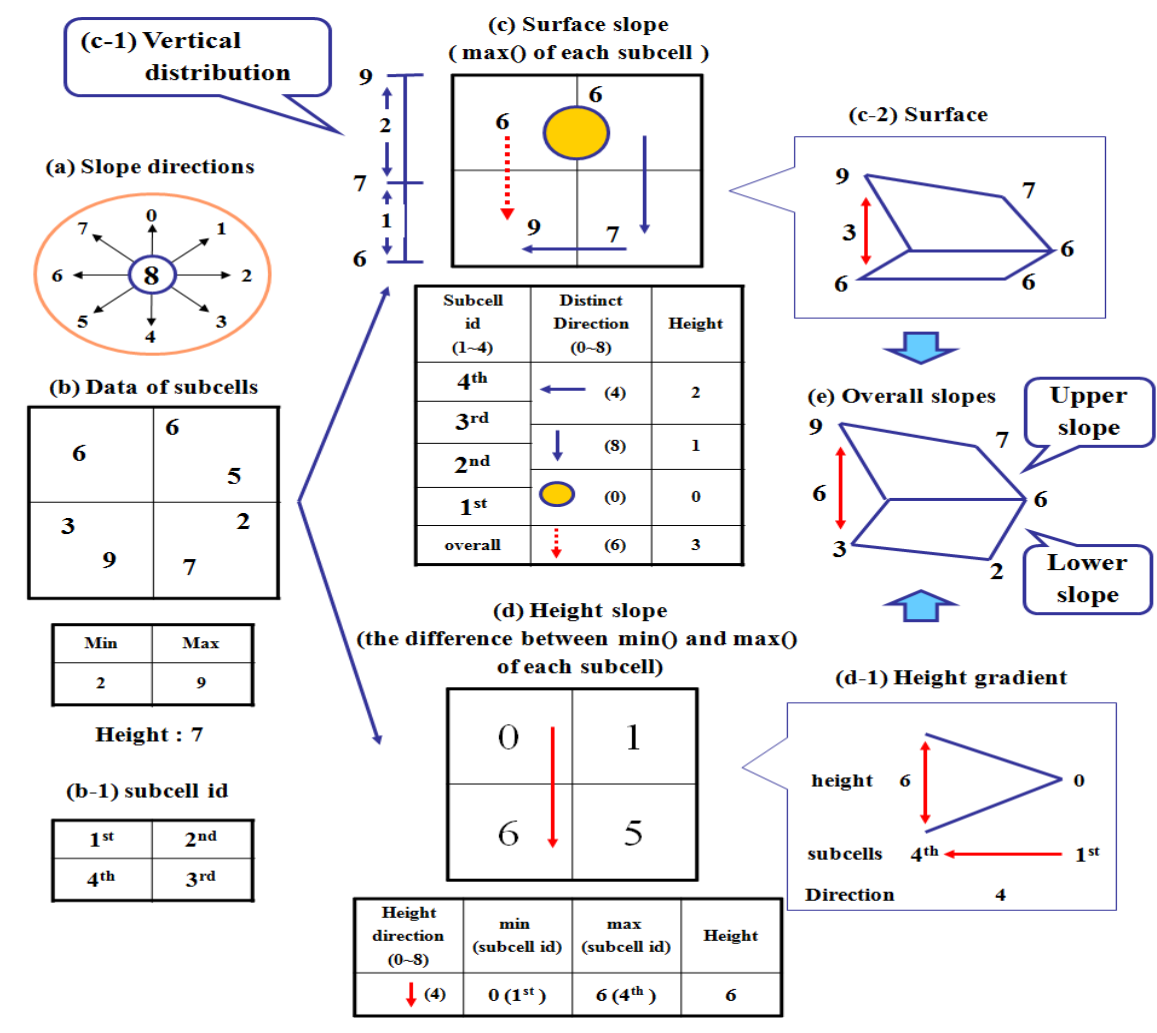
Figure 4. The layered slopes for data abstraction in a